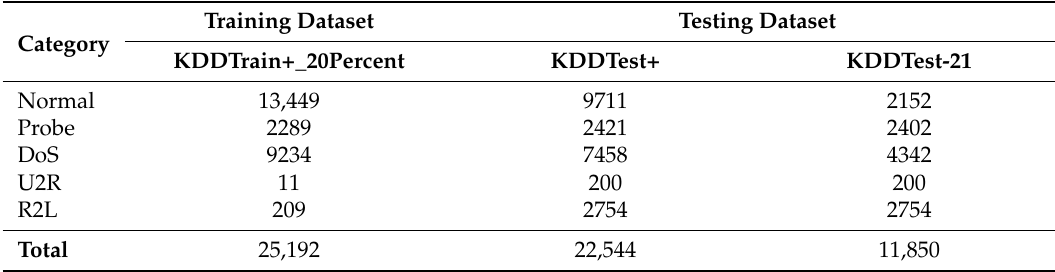
Table 3. The class distribution of the NSL-KDD dataset.